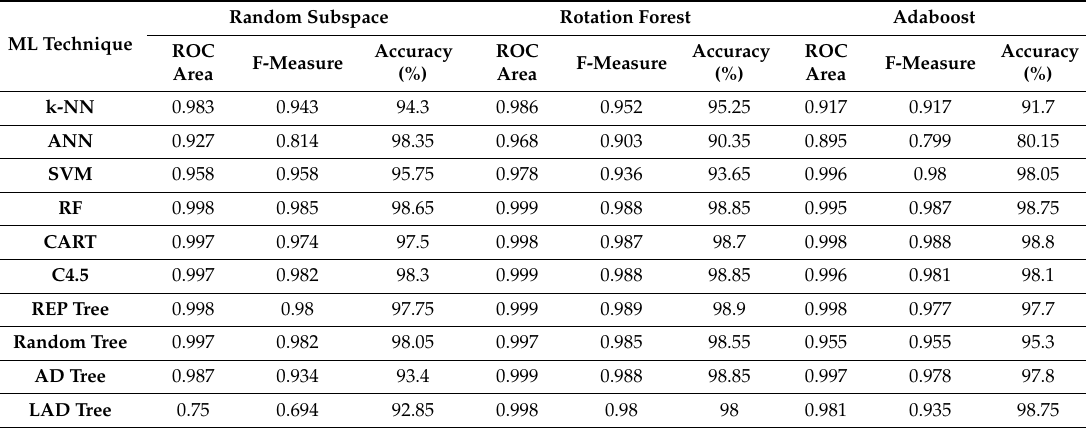
Table 2. Performance of classification method (Random Subspace, Rotation Forest, Adaboost). ML